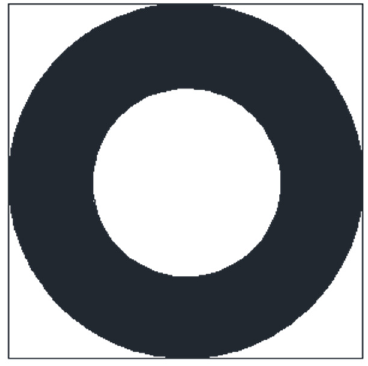
Figure 4. Ring mark. Figure 4. Ring